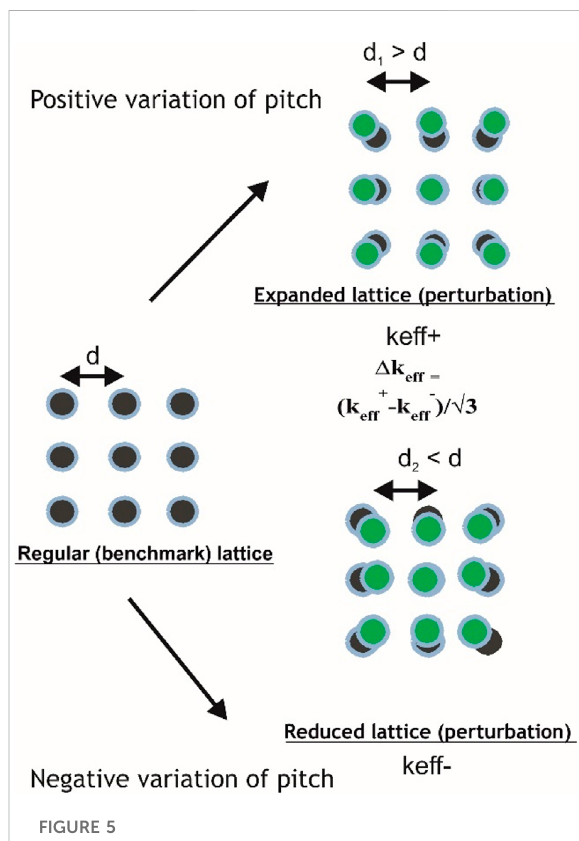
FIGURE 5 Traditionalmethodforevaluationofpitchuncertainty.disthe pitch, d 1 correspond with a positive variation of pitch; keff+ is the resulting keff; d 2 correspond with a negative variation of pitch. keff − is the resulting